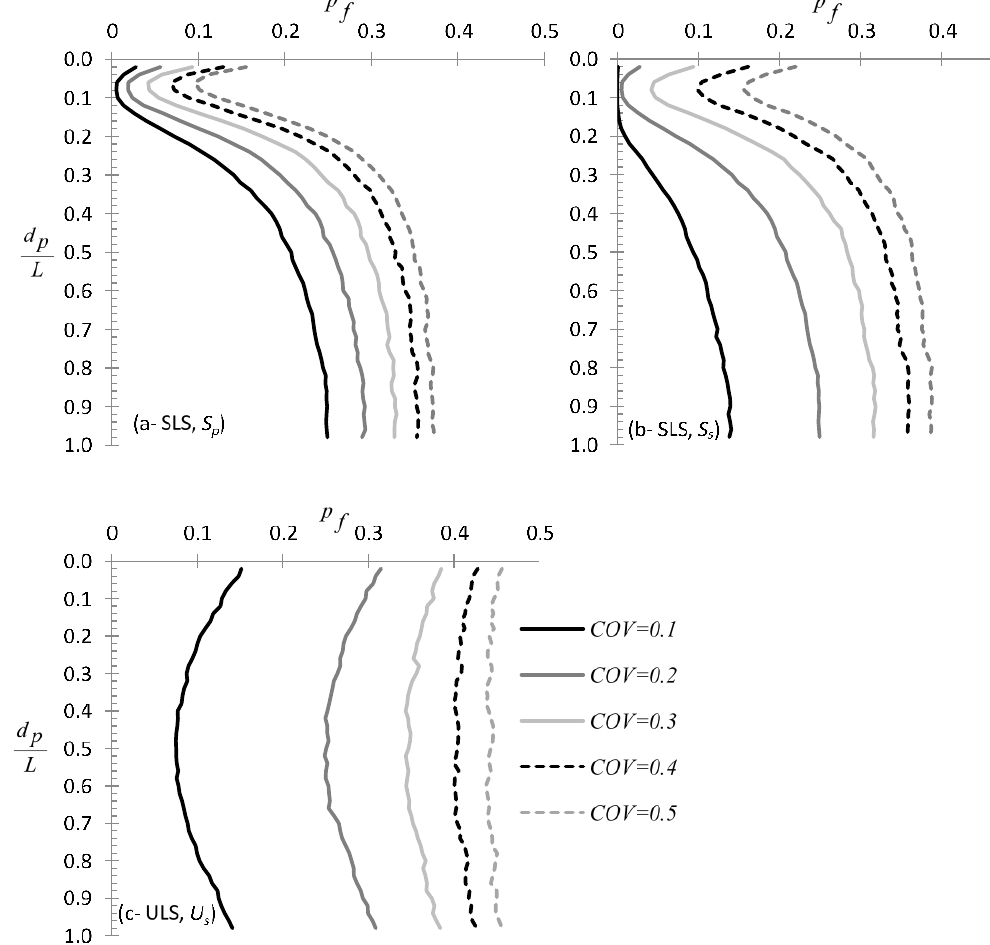
Figure 6. p f vs. d p / L curves for di ff erent values of COV of ( a ) S p ( SLS state), ( b ) S s ( SLS state), and ( c ) U s d L curves for different values of COV of ( a ) Figure 6. f p vs. ( ULS state) for θ / L = 2 / p U ( ULS state) for L   2/3. state), and ( c ) s